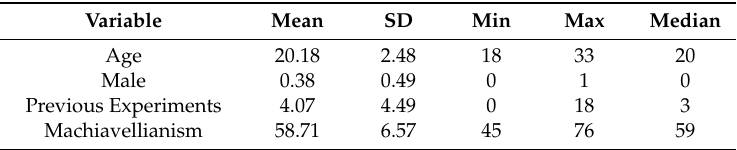
Table A1. Dictator